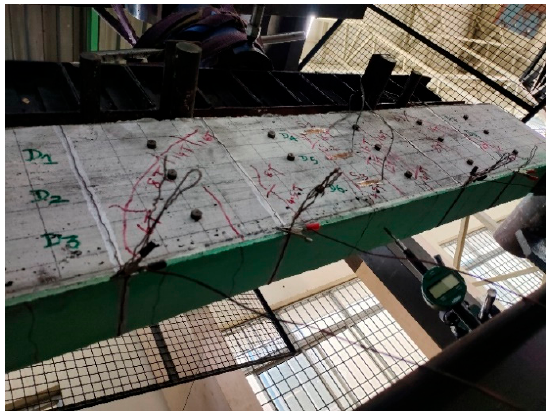
Figure 4. Four–probe method with wire winding on smart mortar.